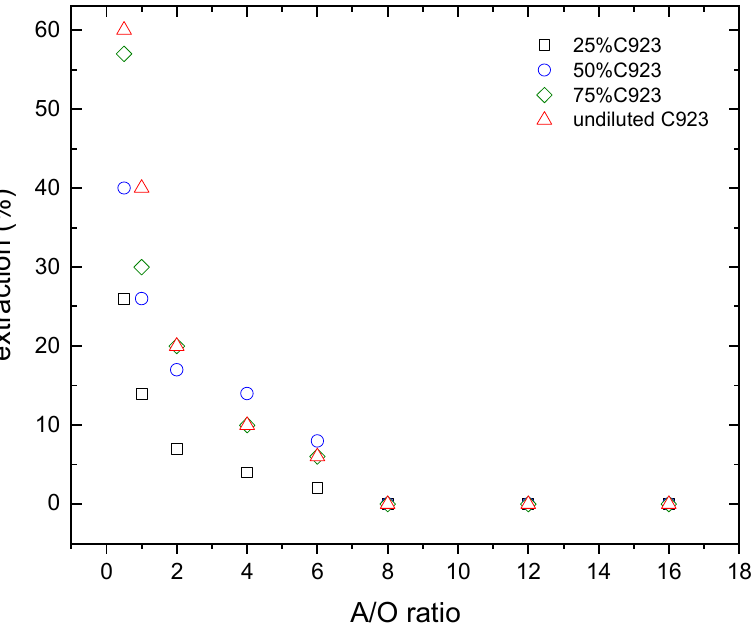
Figure 5. Nitric acid extraction at various Cyanex 923 concentrations. Temperature: 20 °C.